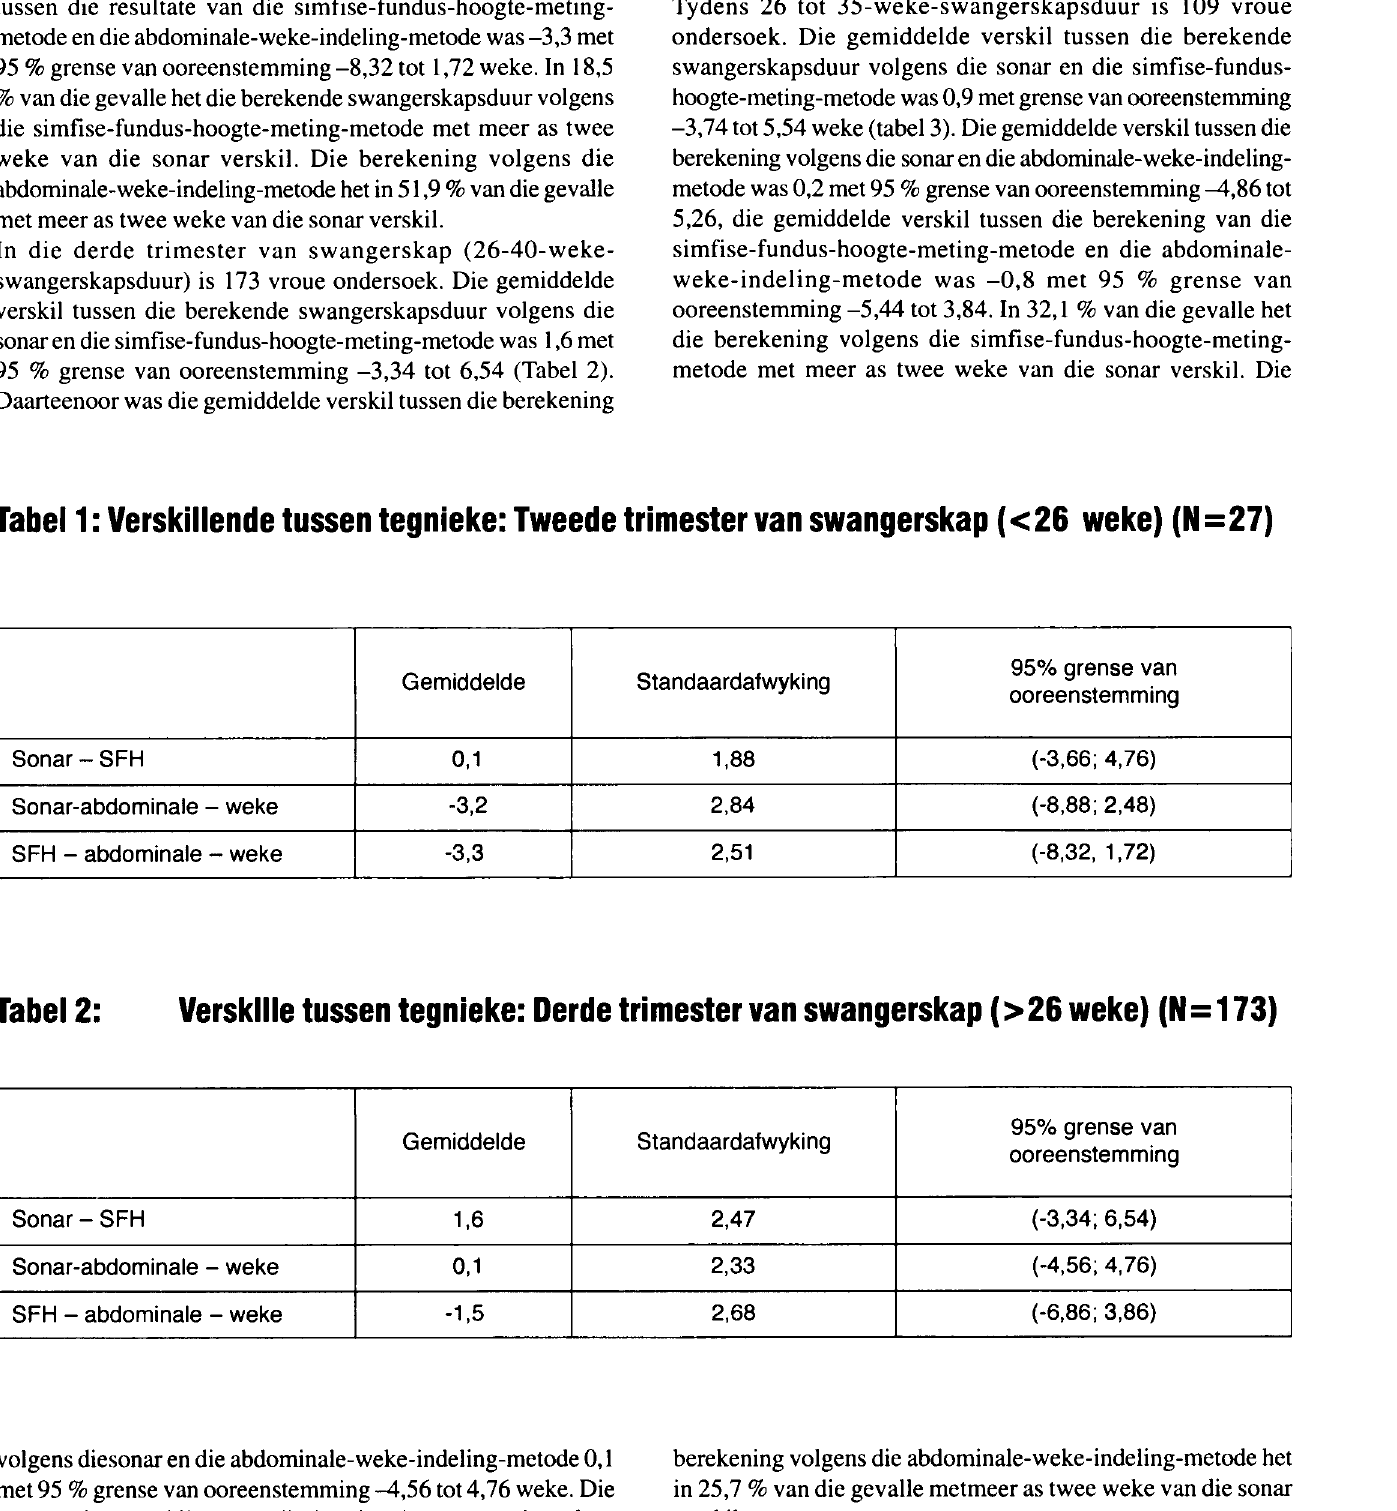
Tabel 1: Verskillende tussen tegnieke; Tweede trimester van swangerskap (< 2 6 weke)